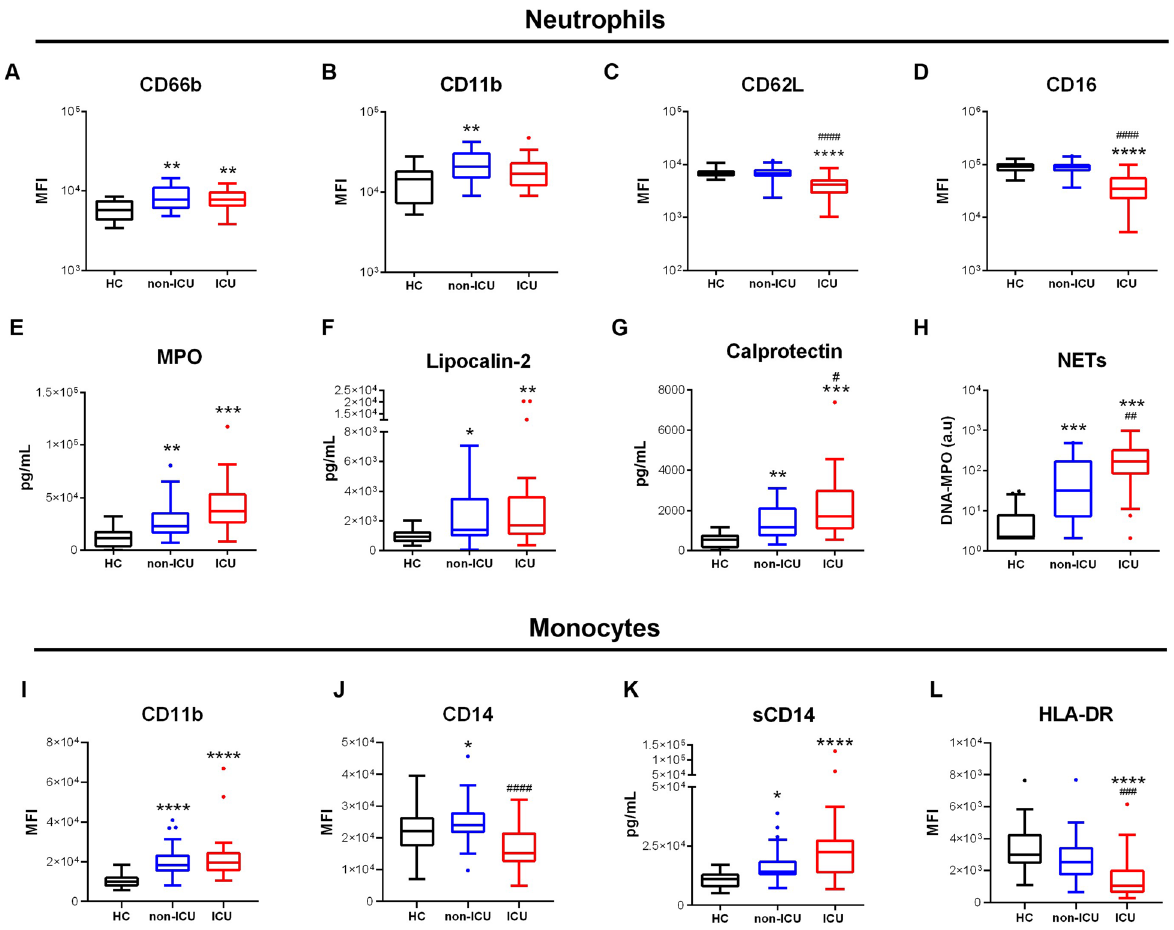
Figure 1. Circulating phagocytes are activated in severe COVID-19. ( A – D ) Expression of activation markers CD66b ( A ), CD11b ( B ), CD62L ( C ), CD16 ( D ) on neutrophils by flow cytometry. ( E – H ) Concentration in plasma of myeloperoxidase (MPO, E ), lipocalin-2 ( F ), calprotectin ( G ) and NETs ( H ) in COVID-19 patients and controls. ( I , J ) Surface expression of CD11b ( I ) and CD14 ( J ) on monocytes. ( K ) Soluble CD14 concentration in plasma. ( L ) Surface expression of HLA-DR on monocytes. Intergroup comparison by Mann–Whitney U test between healthy controls and ICU or non-ICU patients: ****P < 0.0001, ***P < 0.001, **P < 0.01, *P < 0.05, between non-ICU and ICU patients: #### P < 0.0001, ### P < 0.001, ## P < 0.01, # P < .05. All boxplots whiskers represent 10th and 90th percentiles. HC healthy